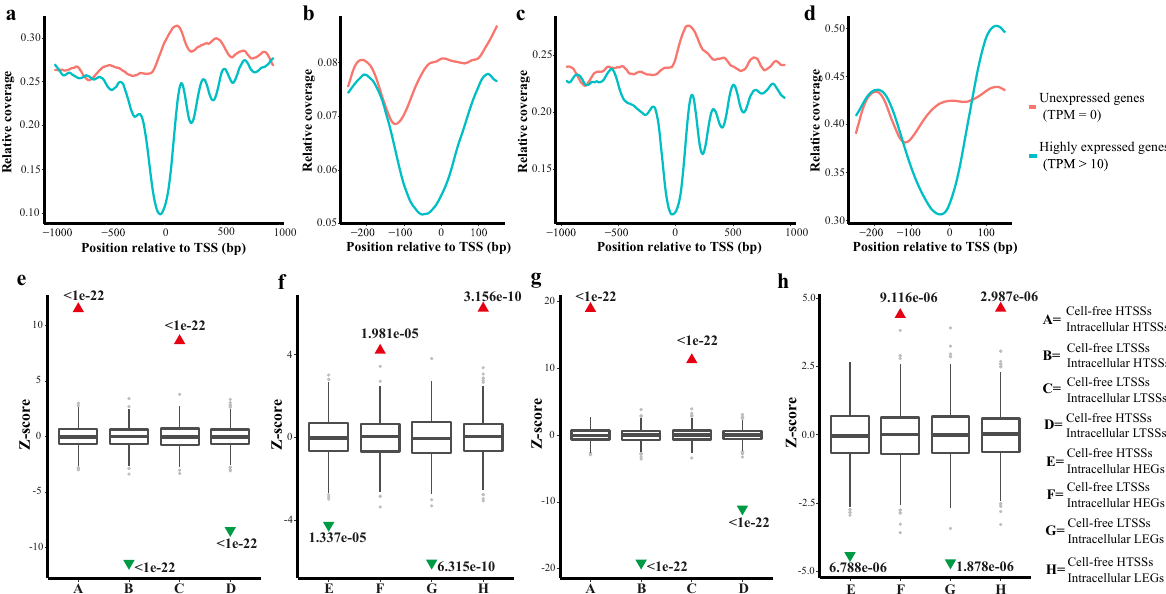
Fig. 3 The cfDNA nucleosome footprint of cell supernatant reveals intracellular nucleosome positioning and gene expression. DNA read depth maps of the TSSs by MNase-seq for highly expressed genes (TPM > 10, blue) and unexpressed genes (TPM = 0, red) in the MDA-MB-231 cell line ( a ) and T-47D cell line ( b ) and cfDNA-seq for highly expressed genes (TPM > 10, blue) and unexpressed genes (TPM = 0, red) in the MDA-MB-231 cell line ( c ) and T-47D cell line ( d ). Overlaps of DTSSs (different high coverage depths around TSSs) in cfDNA-seq and MNase-seq of the MDA-MB-231 cell line ( e ) and T-47D cell line ( f ) and DTSSs by cfDNA-seq and DEGs (differentially expressed genes) matched by mRNA- seq of the MDA-MB-231 cell line ( g ) and T-47D cell line ( h ). Box plots represent the expected null distribution of overlaps from 1000 permutations (two sided, p values computed using a standard normal distribution). The extremes of the boxes de fi ne the upper and lower quartiles, and the center lines de fi ne the median. Whiskers indicate 1.5 times the interquartile range (IQR). Triangles represent observed overlap (red if signi fi cantly enriched, green if signi fi cantly